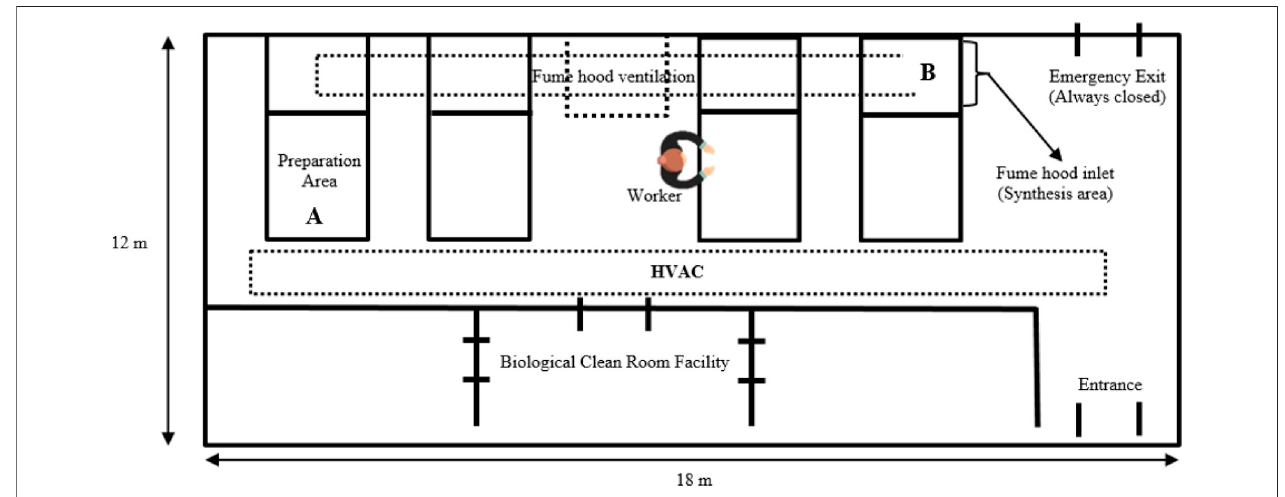
FIGURE 1 | Schematic layout of the synthesis laboratory fi tted with a heating, ventilation and air conditioning system (HVAC). C. Description of the ventilation systems.